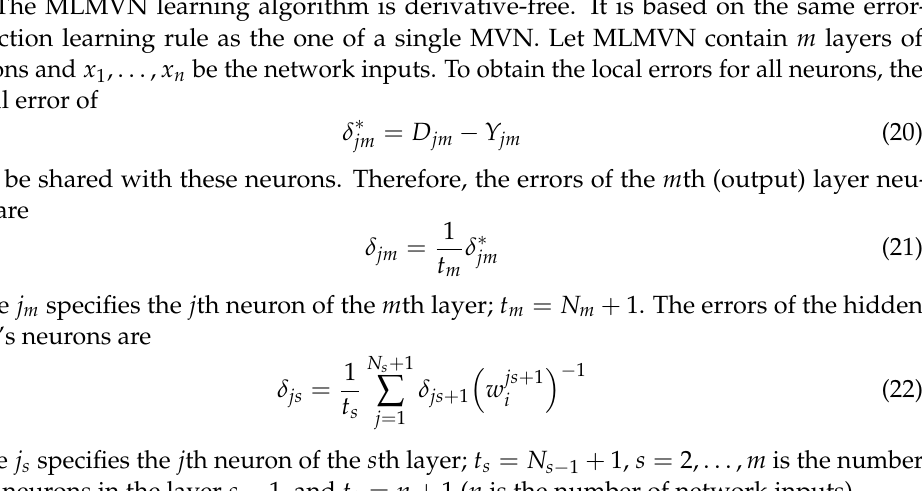
Figure 3. MVN training based on error-correction rule.